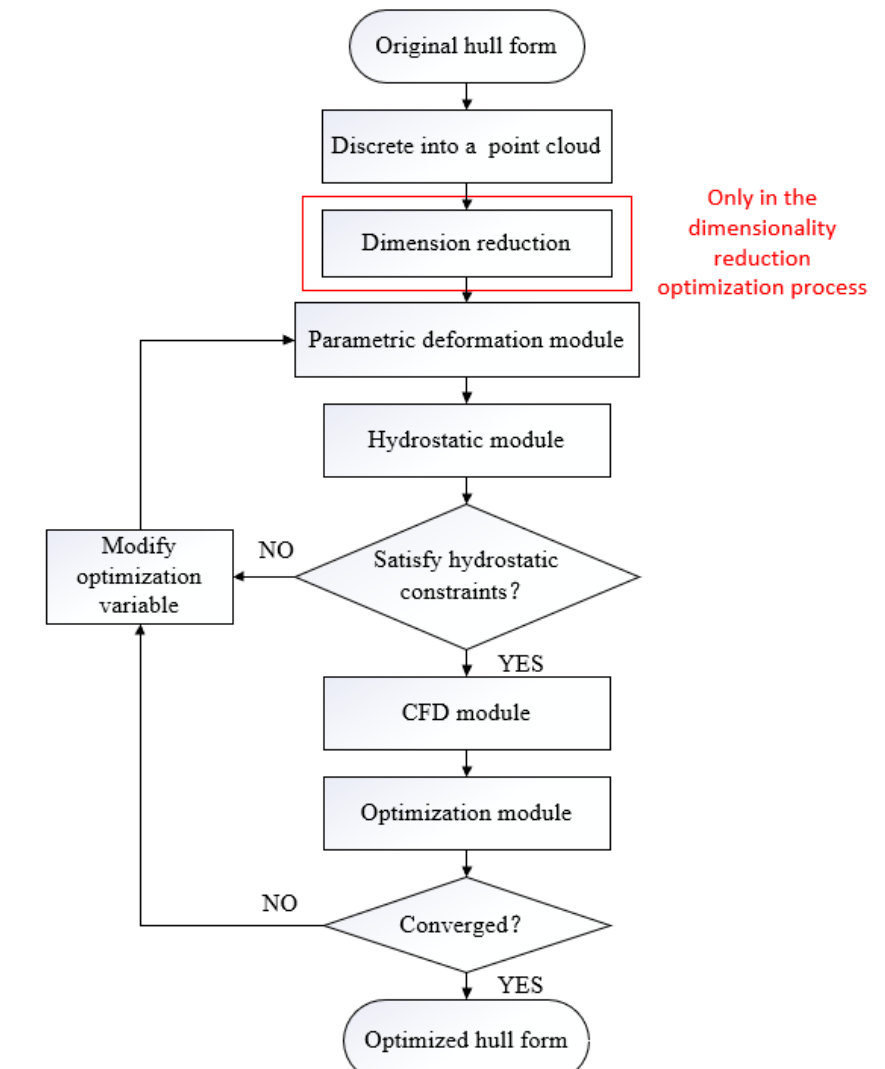
Figure 14. Optimization process based on the SHIPMDO-WUT platform.